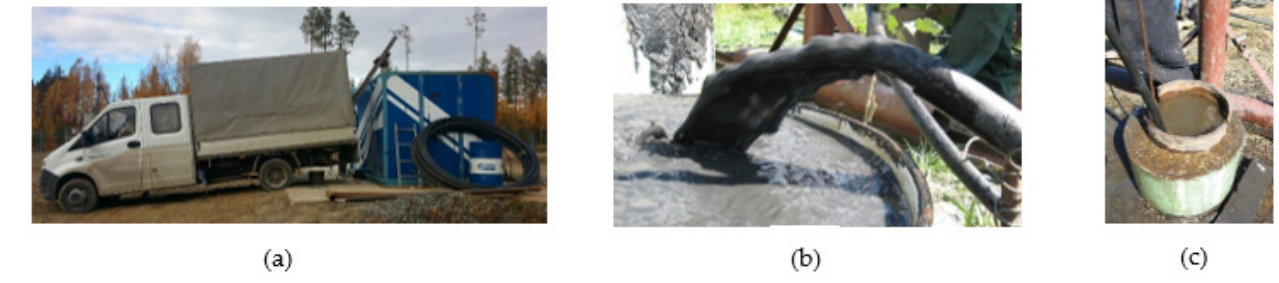
Figure 13. Sets of nozzles ready for well cleaning. ( a ) Cavitation nozzles, ( b ) hydrodynamic conic nozzles.